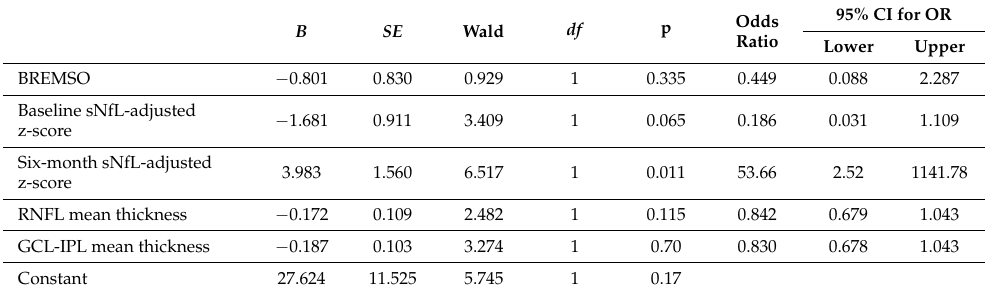
Table 4. Logistic regression predicting likelihood of EDSS-plus progressor state based on baseline and 6-month follow-up adjusted z-score, OCT parameters (RNFL and GCL-IPL) and BREMSO score. B